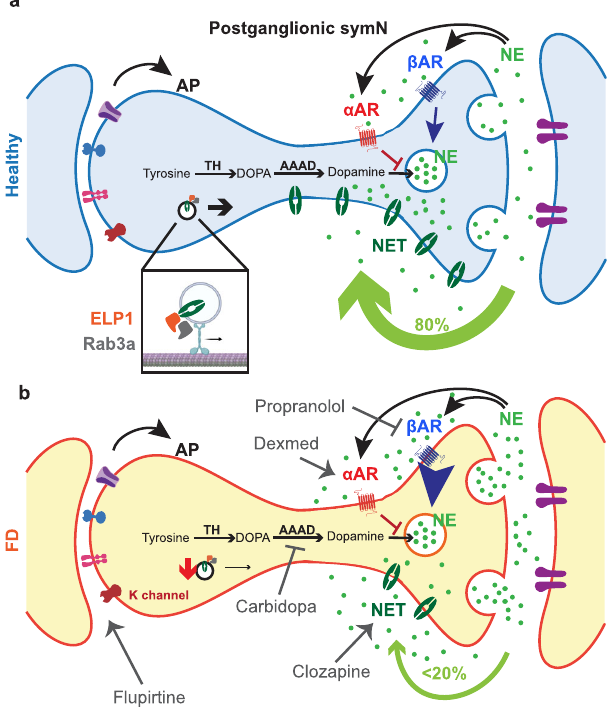
Fig. 6 | Model. In healthy postganglionic sympathetic neurons (symNs) ( a ), nor- epinephrine (NE) secretion in the axon terminal is properly regulated by nor- epinephrine transporter (NET), which reuptakes about 80% of released NE, α adrenergic receptors ( α AR), which downregulate NE secretion and β adrenergic receptors ( β AR), which upregulate NE secretion. NET is traf fi cked to the cell membrane with the help of RAB proteins. In FD symNs ( b ), NET expression is decreased, leading to oversecreted NE. NET traf fi cking might be affected by the downregulation of RAB3A. In addition, our results indicate that β AR in FD symNs mighthavestrongerresponsethanhealthysymNs,whichmightfurtherstrengthen thereleaseofNEandsymNactivity.Severaltherapeutictargetsareidenti fi edinthis study using a selection of clinical compounds: fl upirtine activates potassium channels (K channel) and induces neural depolarization; carbidopa blocks NE synthetic pathway and thus reduces NE overspill; dexmedetomidine (Dexmed) activates α AR while propranolol inhibits β AR. All these drugs suppress FD symN hyperactivity in